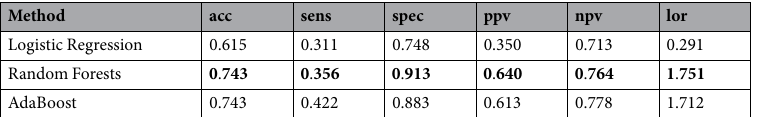
Table 24. Performance of prediction for TD/PIGD class label on Michigan dataset.